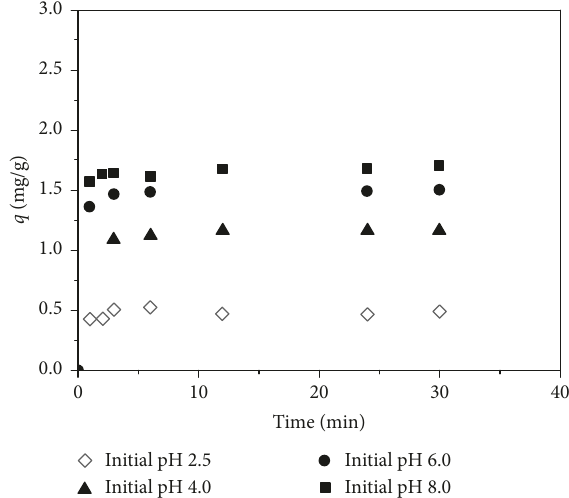
20mg/L, T 25 ° C, adsorbent (cid:30) (cid:30) powder, and 1100rpm. (cid:30)